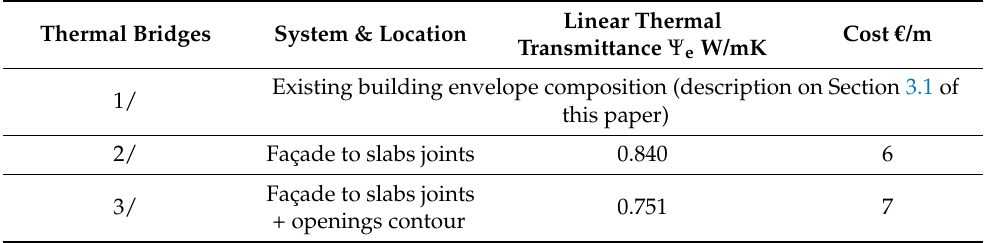
Table 2. Proposed renovation measures for thermal bridges.